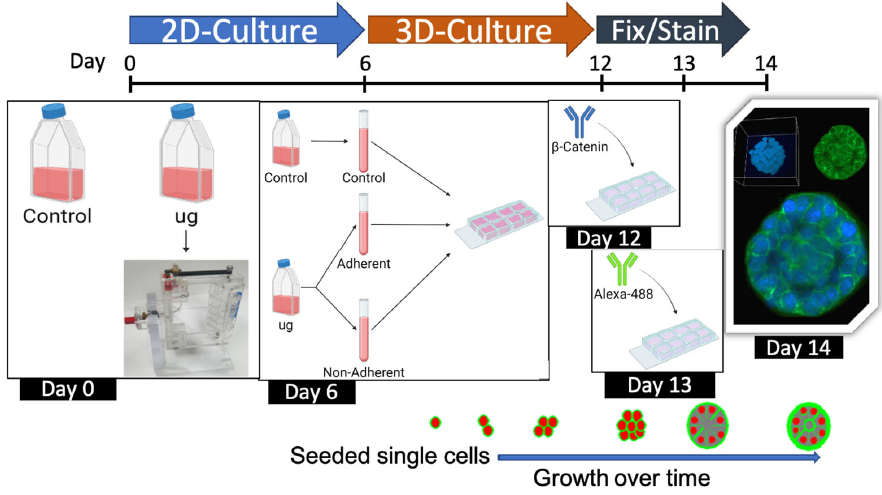
Figure 9. Overview of the culturing, treatment, and set up for both 2D and 3D